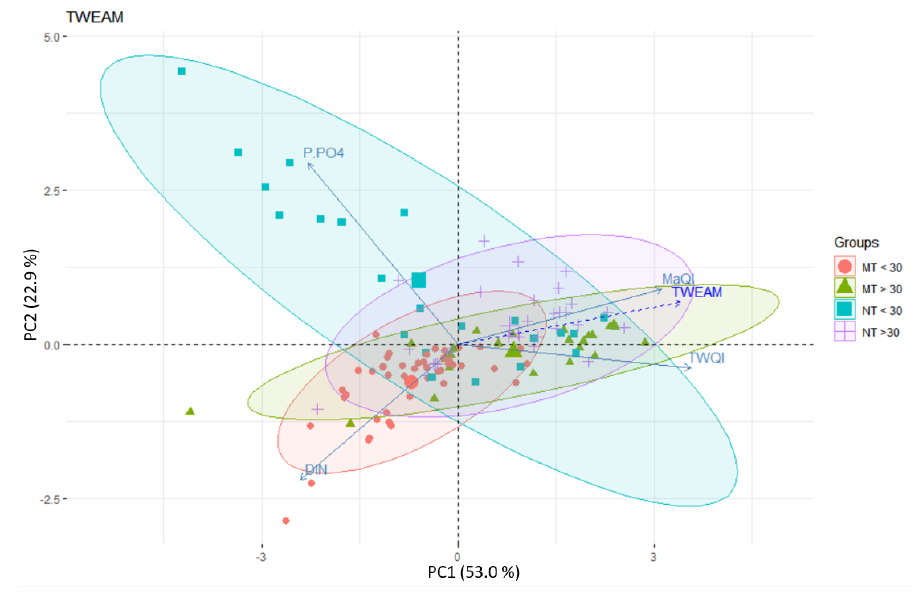
Figure 9. PCA biplot of the two main components for the whole dataset, including the TWEAM